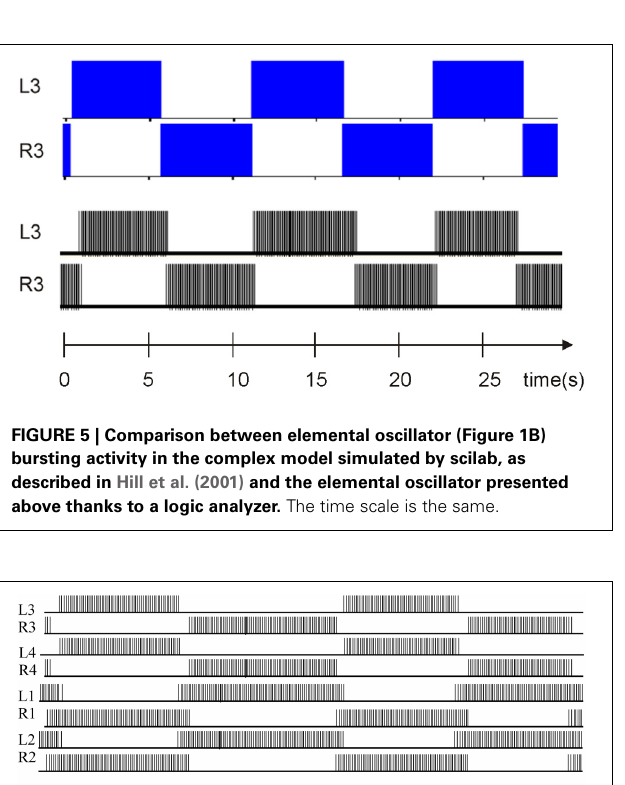
COMPARISON OF BIOLOGICAL/DIGITAL SEGMENTAL